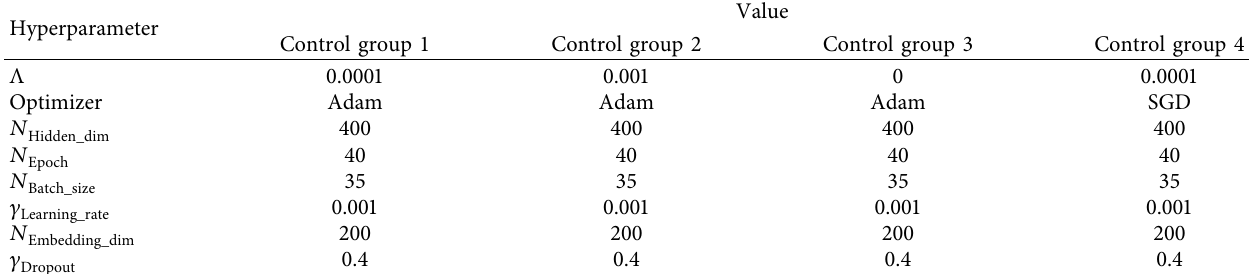
Table 1: Model hyperparameter settings.